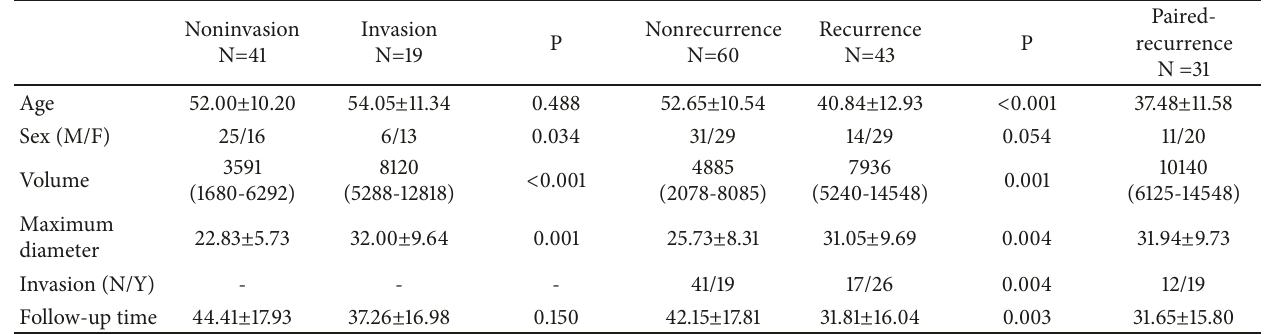
Table 1: Characteristics of the cohort.